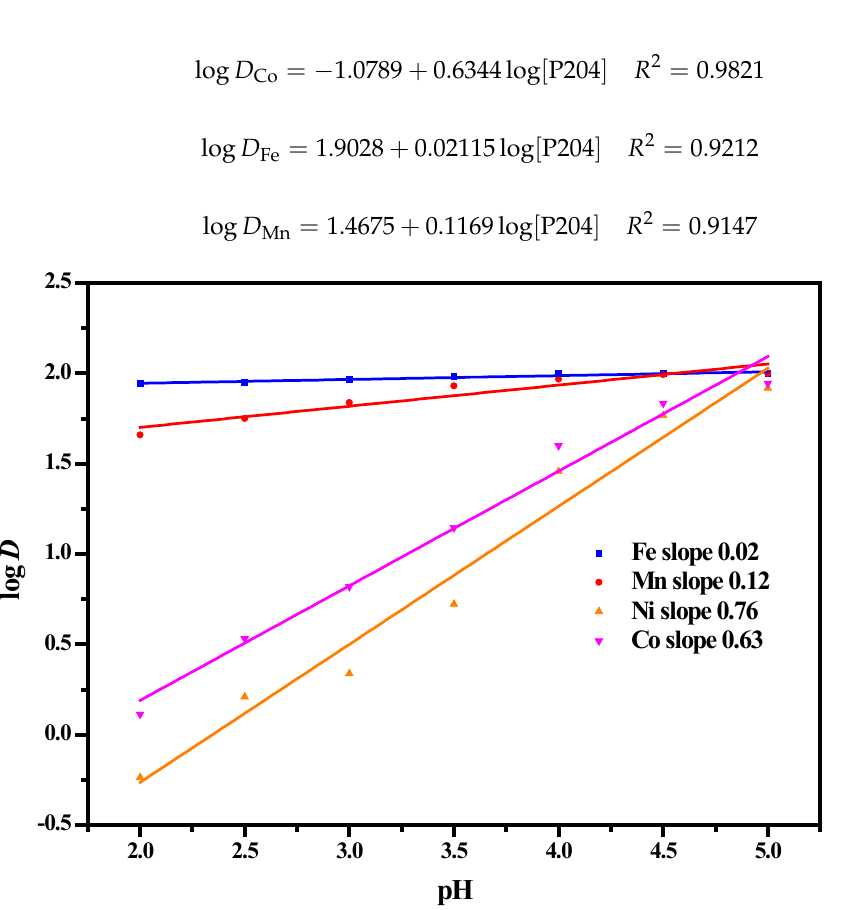
Figure 13. log D —logpH diagram of Fe and Mn.